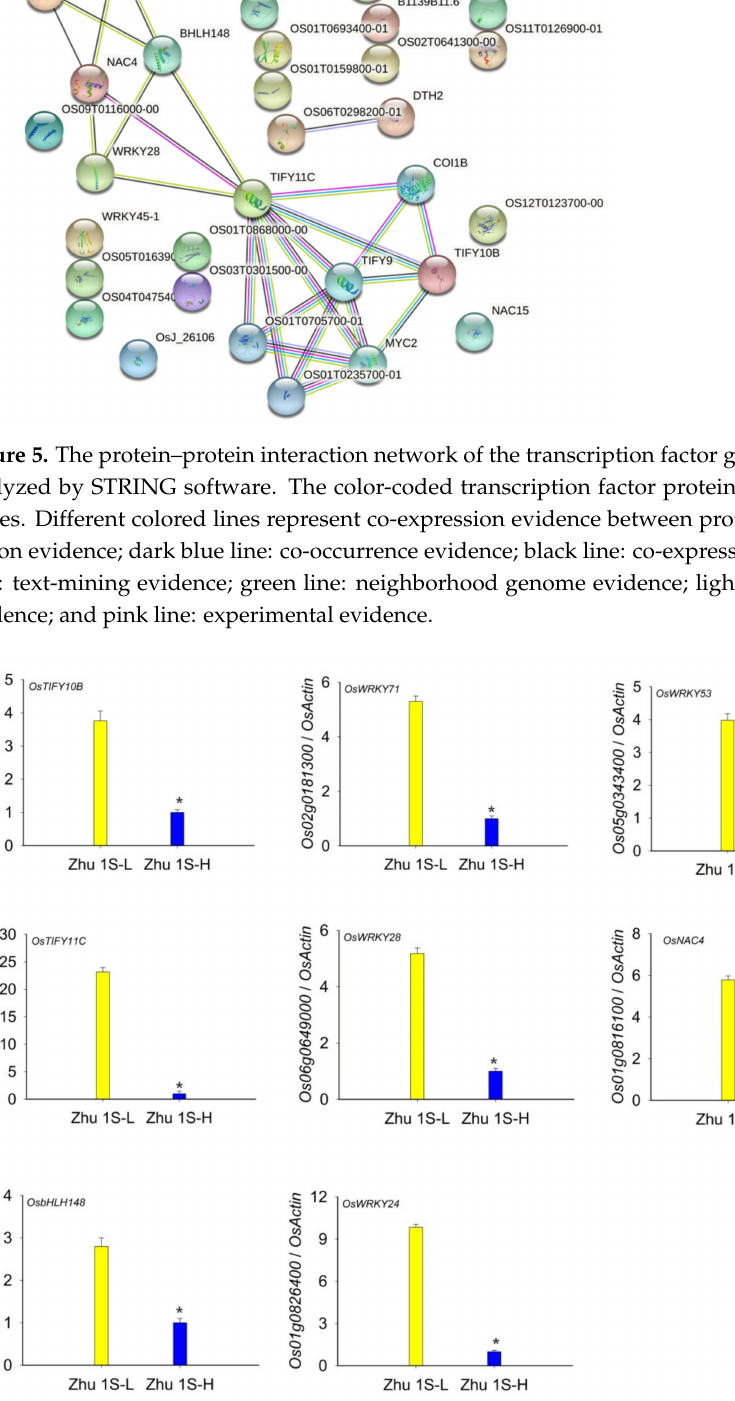
Figure 6. Differential expression levels of nine transcription factors validated by quantitative real- time PCR. OsActin1 as an internal control. The experiment was repeated three times with similar results. Data are means of five replicates of one experiment. Asterisks represent significant differences. Error bars represent ±